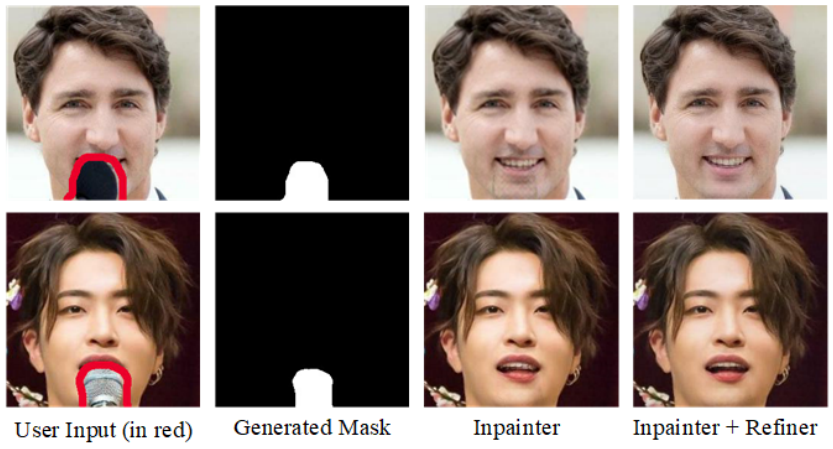
Figure 1. Microphone removal results of MRGAN on real world